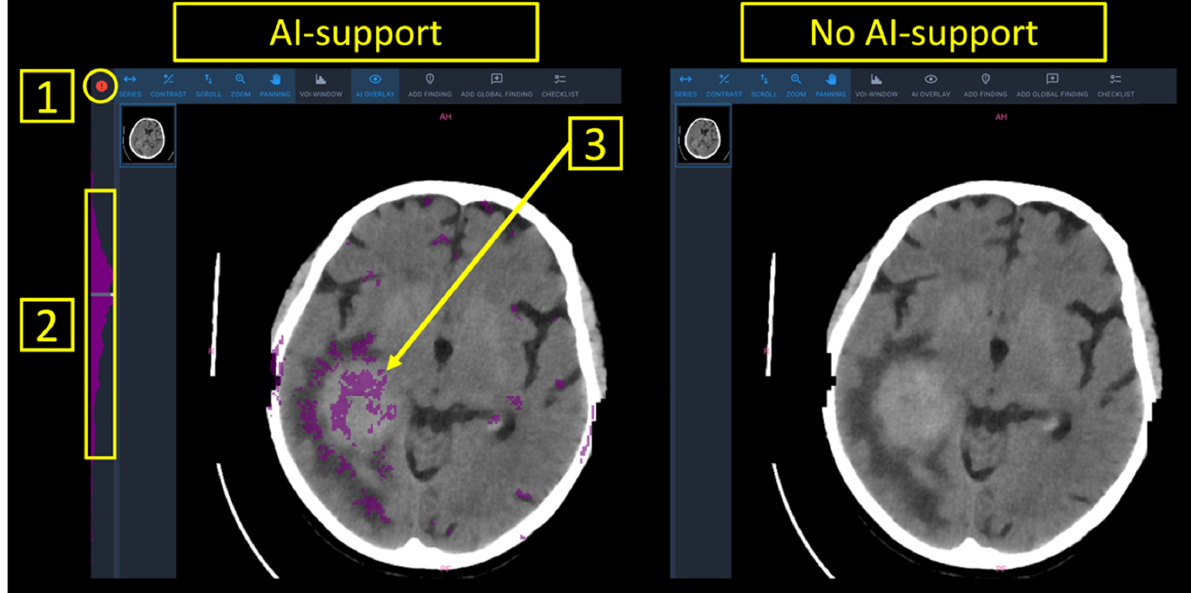
Figure 1. Reporting interface with and without AI support. Note that AI support provided patient- level predictions “normal” (green), “inconclusive” (white) or “pathological” (red), as highlighted by ( 1 ). Furthermore, pixel-wise segmentations of suspected pathology ( 3 ), as well as the distribution of anomalous pixels within the stack of CT images ( 2 ) were